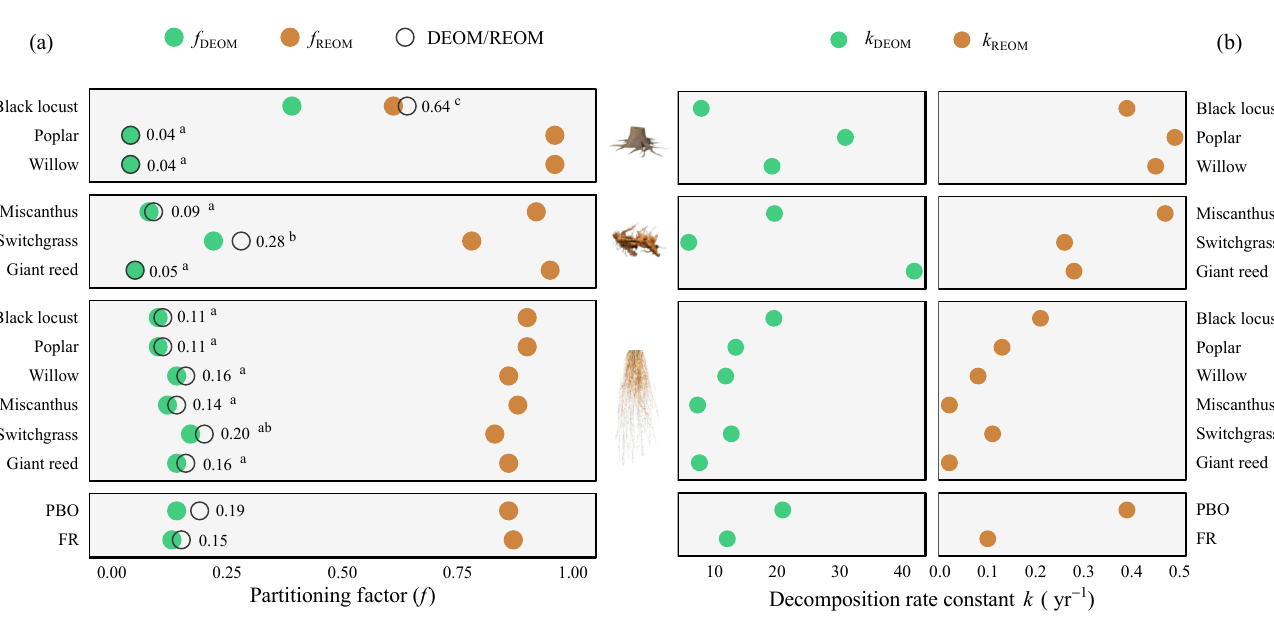
Figure 4. Mean values of partitioning factor ( f ) ( a ) and decomposition rate constant ( k ) ( b ) for different exogenous organic matter types as obtained by the improved version of the RothC model [26]. DEOM/REOM is the ratio of f DEOM / f REOM Different superscript letters show statistically different means among PBCs (Tukey’s test, p : 0.05) across all EOM types. On average f REOM and f DEOM values were, respectively, 0.14 and 0.87 for PBO and 0.13 and 0.86 for FR. No differences were found among EOM types for partitioning factor ( f ) for DEOM and REOM expect for switchgrass and black locust, which resulted in the PBCs with the highest f DEOM , respectively, of 0.22 and 0.39. Mean values of DEOM/REOM ratio for PBO (0.06) and FR (0.15) were significantly different if from the average are